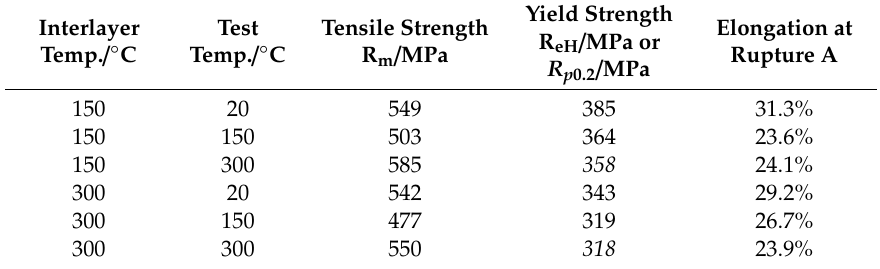
Table 3. Average monotonic properties at di ff erent temperatures in the crosswise extraction